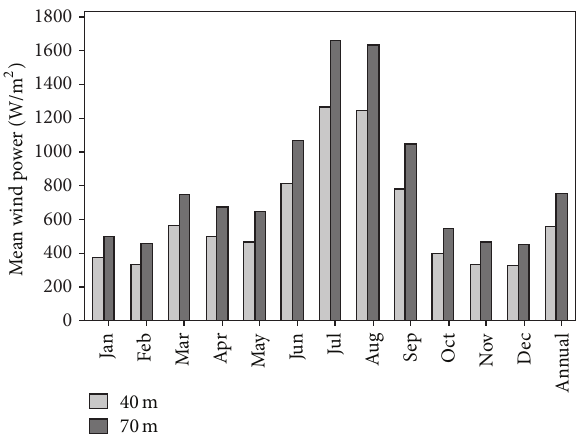
Figure 3: Monthly and annual mean wind speed (m/s) at 40 and 70 heights.